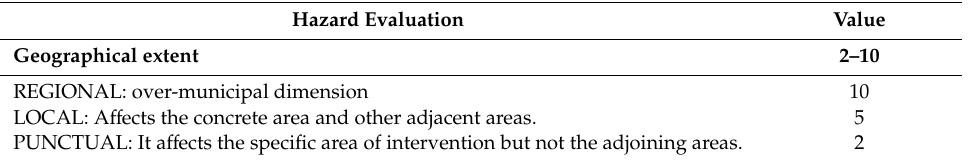
Table A1. Disaggregation of rankings for the participatory environmental hazard evaluation proposed in Valles Cruceños region. Each impact feature (geographical extent, duration, probability, severity, reversibility) was assigned in a focus group discussion. Aggregated hazard values were calculated as the sum of each impact feature